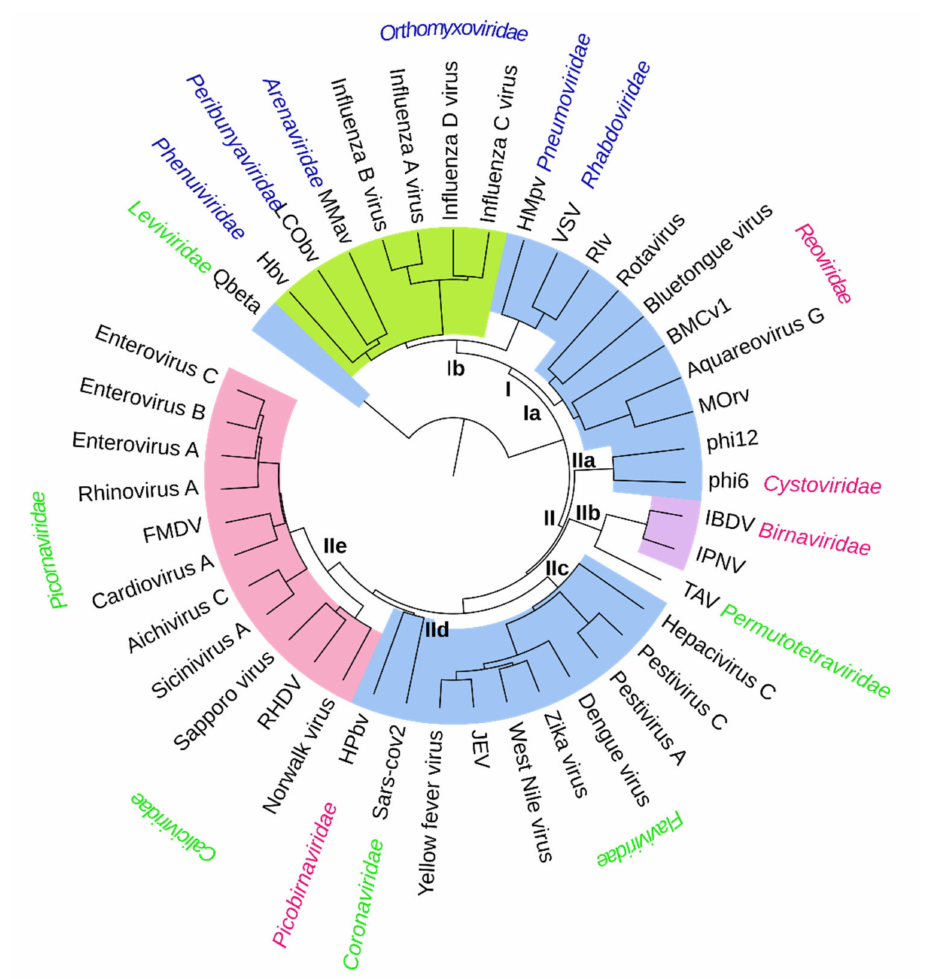
Figure 2. A structure-based phylogenetic tree for the polymerase subunits of RNA viruses deduced based on the structural alignment of the common core. The name of the virus (black) and the viral family are indicated at the tips of the branches. The coloring of the family name reflects the nature of the viral genome: green, positive-strand RNA; blue, negative-strand RNA; and red, double-stranded RNA. The polymerases using solely primer-independent initiation are indicated with blue background, polymerases using VPg-protein primer with pink background, polymerases applying self-priming with purple background, and polymerases using RNA-priming on (+)strand synthesis with green background. Background is white if the initiation mechanism is unclear. Moreover, in this case, there is biochemical and structural evidence that suggests a primer-independent initiation mechanism [43]. The applied abbreviations are: BMCv1: Bombyx Mori cypovirus 1, FMDV: foot-and-mouth disease virus, Hbv: Huaiyangshan banyangvirus, HPbv: human picobirnavirus, HMpv: human metapneumovirus, IBDV: infectious bursal disease virus, IPNV: infectious pancreatic necrosis virus, JEV: Japanese encephalitis virus, LCObv: La Crosse orthobunyavirus, MMav: Machupo mammarenavirus, MOrv: mammalian